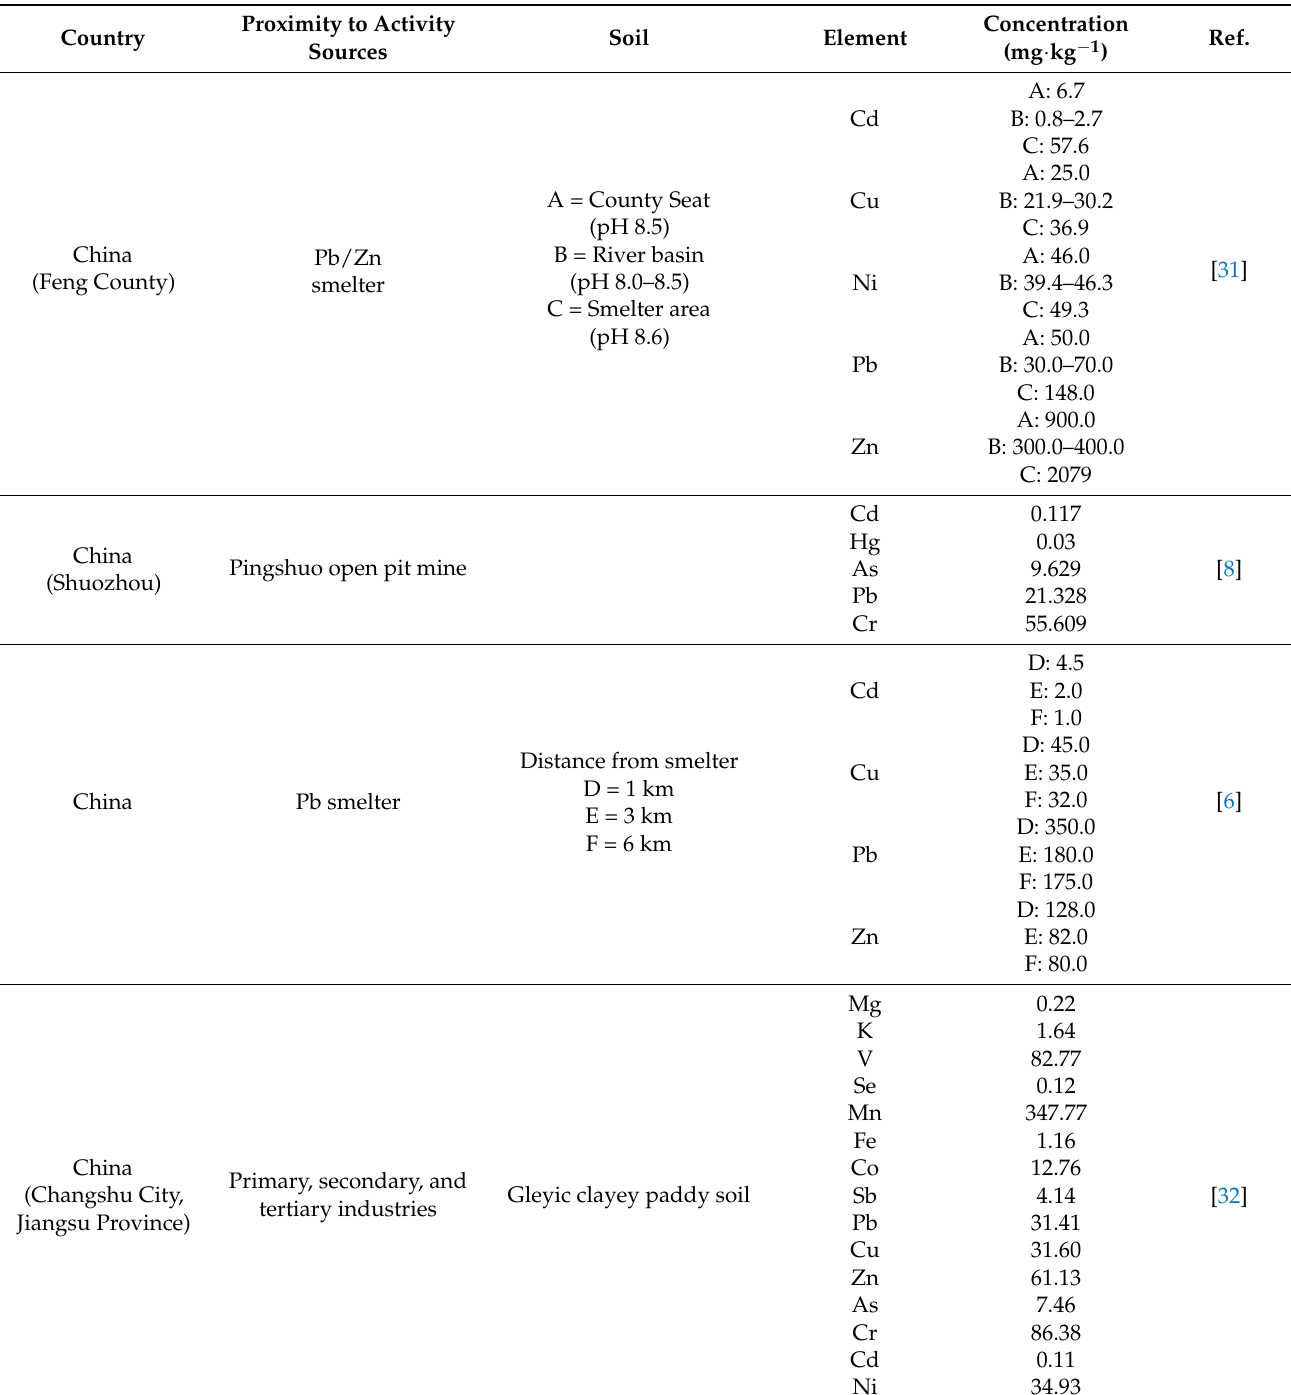
Table 3. Concentration of heavy metals/metalloids in polluted